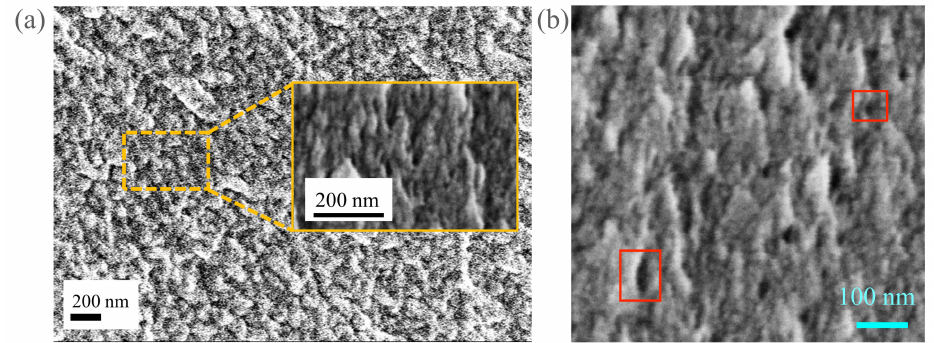
Figure 2. ( a ) Representative SEM image of the Nafion membrane used with approximate nanopore diameter of 20–25 nm. The nanopore size distribution is analyzed with ImageJ image analysis of high-resolution SEM images, such as ( b ). As illustrated, a couple of red boxes in ( b ) enclose typical nanopores, which are many and appear to be black in ( b